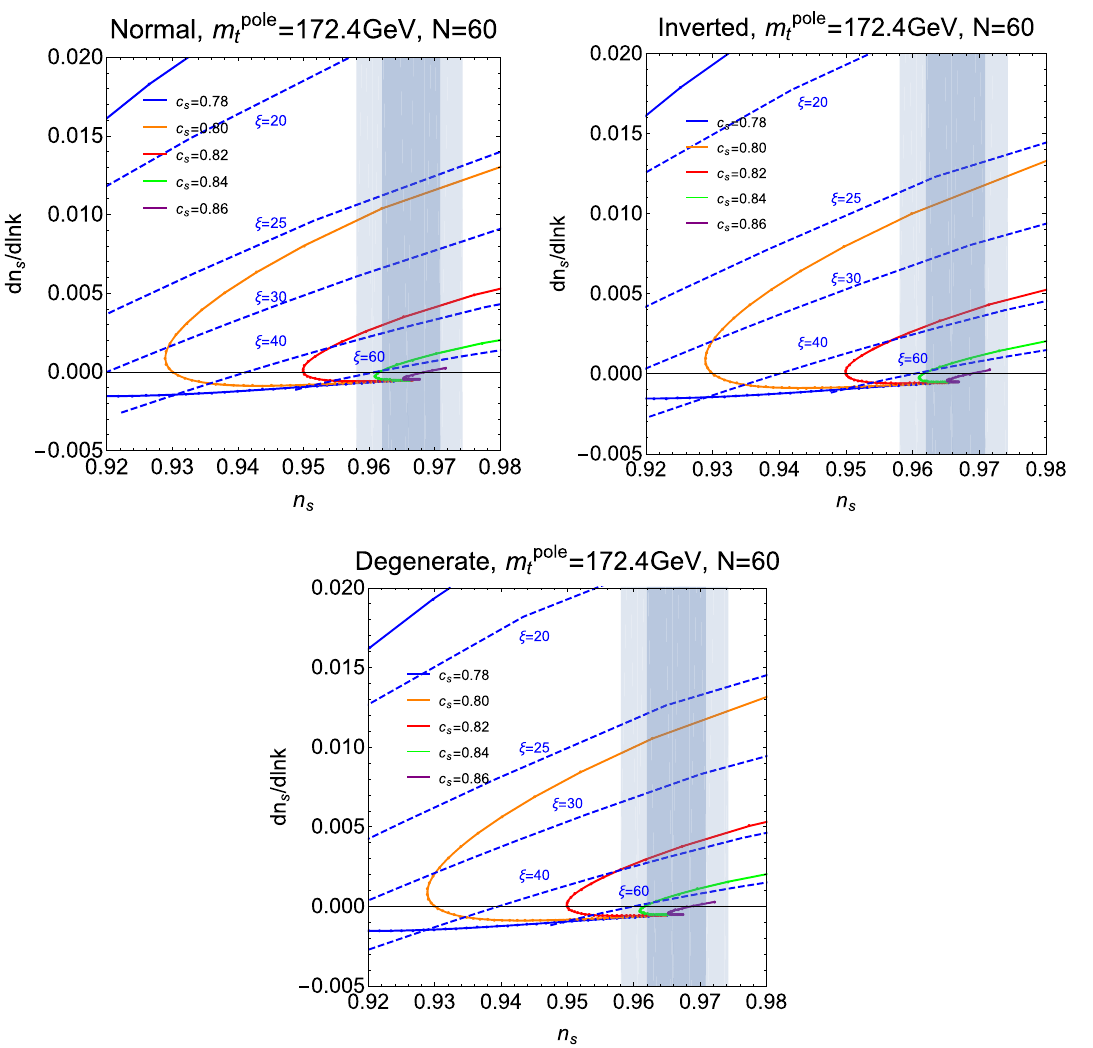
Fig. 7 Upper left (right): n s vs dn s / d ln k in the case of the normal (inverted) hierarchy where c (ξ) is fixed on each solid (dashed) curves. The blue regions correspond to the allowed regions by Planck 2018. Lower: the degenerate